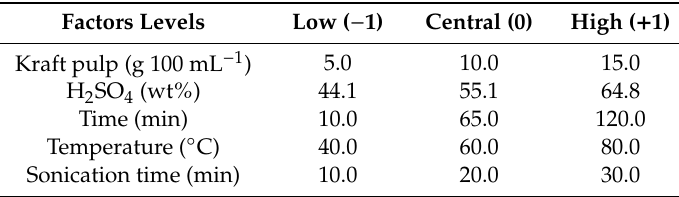
Table 1. Levels of the factors evaluated in the fractional factorial design, sample identification with the corresponding experimental conditions, and the main response evaluated in the yield of cellulose nanocrystals